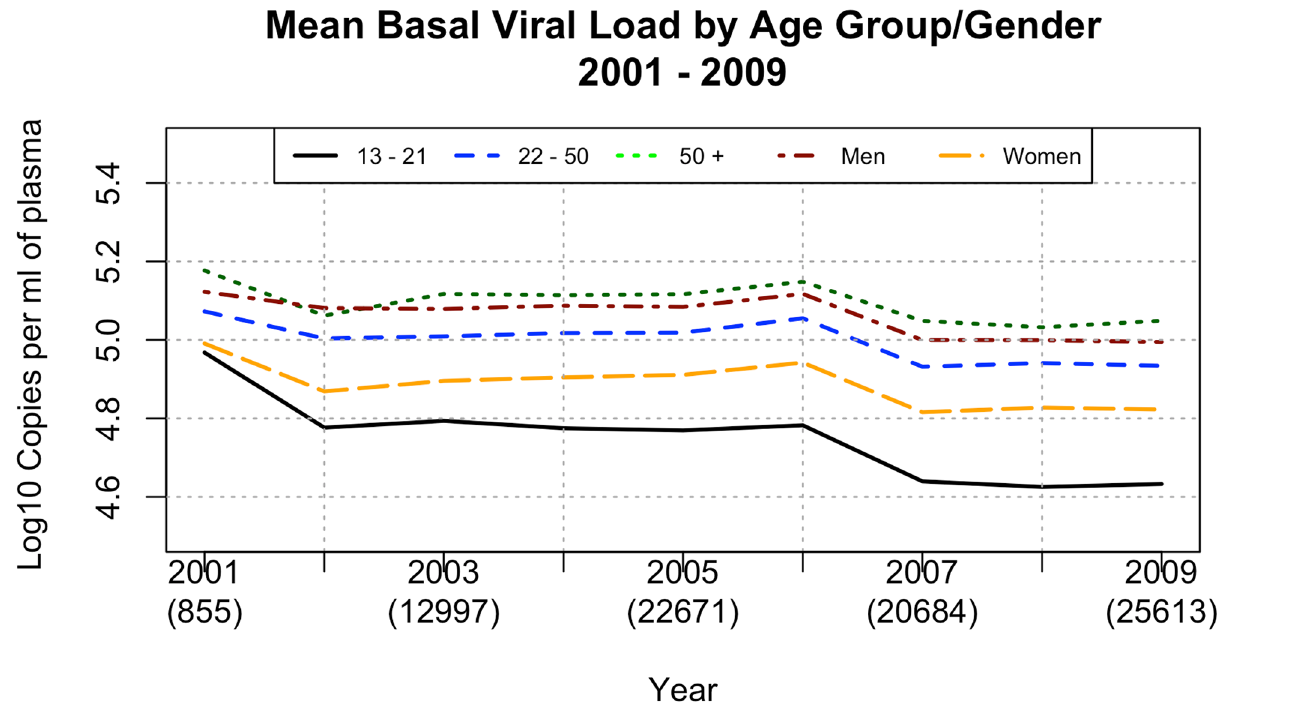
Fig 6. Mean basal viral load. Mean basal viral load by age and gender according to the first measurement for each patient from 2001 to